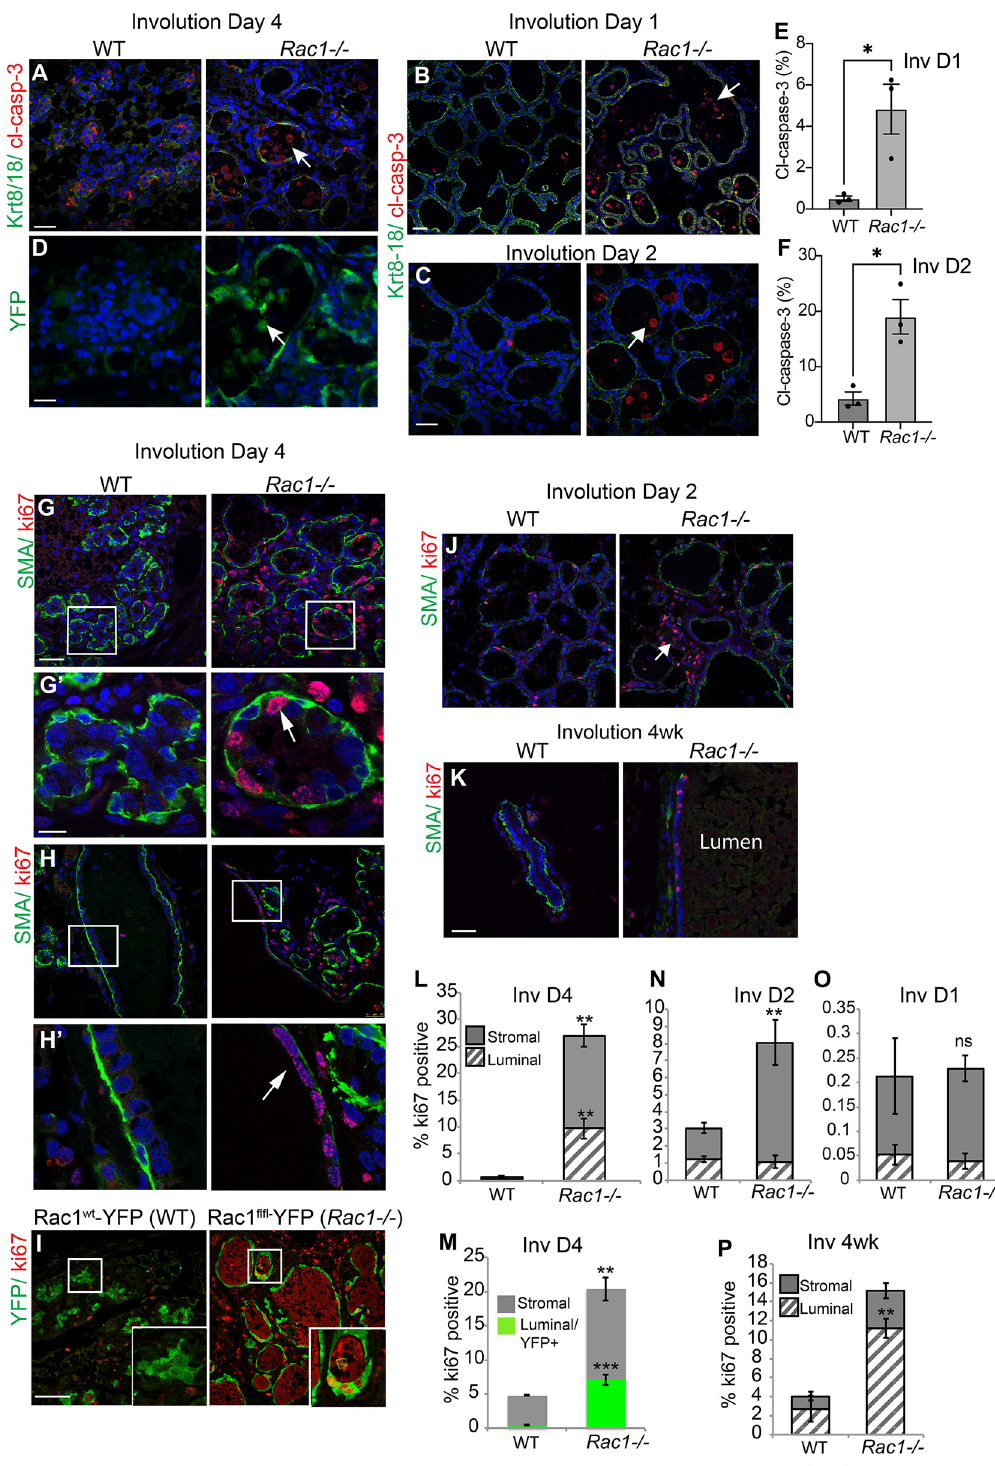
Fig 3. Delayed alveolar regression is not due to impaired cell death but heightened proliferation. ( A - C ) Immunofluorescence staining with cleaved caspase-3 (red) antibody shows numerous dead cells in Rac1−/− alveolar lumens at involution day 4 ( A ) and involution days 1 ( B ) and 2 ( C ). Keratin (Krt) 8/18 (green) was used to detect luminal cells. Note the Krt8-18 antibody cross-reacts with intact keratins in live cells and not cleaved forms in dead cells. Arrows: caspase- positive dead cells in the lumen. Bar: 40 μ m. ( D ) Dead cells in the lumen were confirmed to be of luminal origin with the YFP